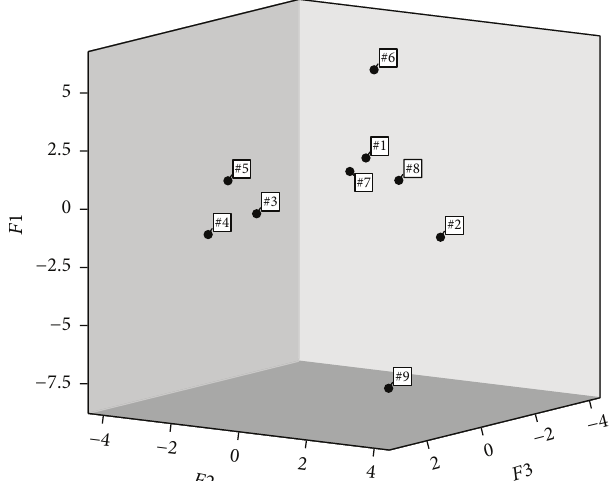
Figure 8: The PCA result of XRD fingerprint of nine Zuotai samples. Note: #1 is the sample of Aba Prefecture Tibetan Medicine Hospital; #2 is the sample of Gan’na Prefecture Tibetan Medicine Hospital; #3, #4, and #5 are the samples of the Company of Tibetan Medicine of Tibetan Traditional Medical College; #6, #7, and #8 are the samples of Qinghai Province Tibetan Medicine Hospital; #9 is the sample of the Company of Tibetan Medicine of Tibetan Autonomous